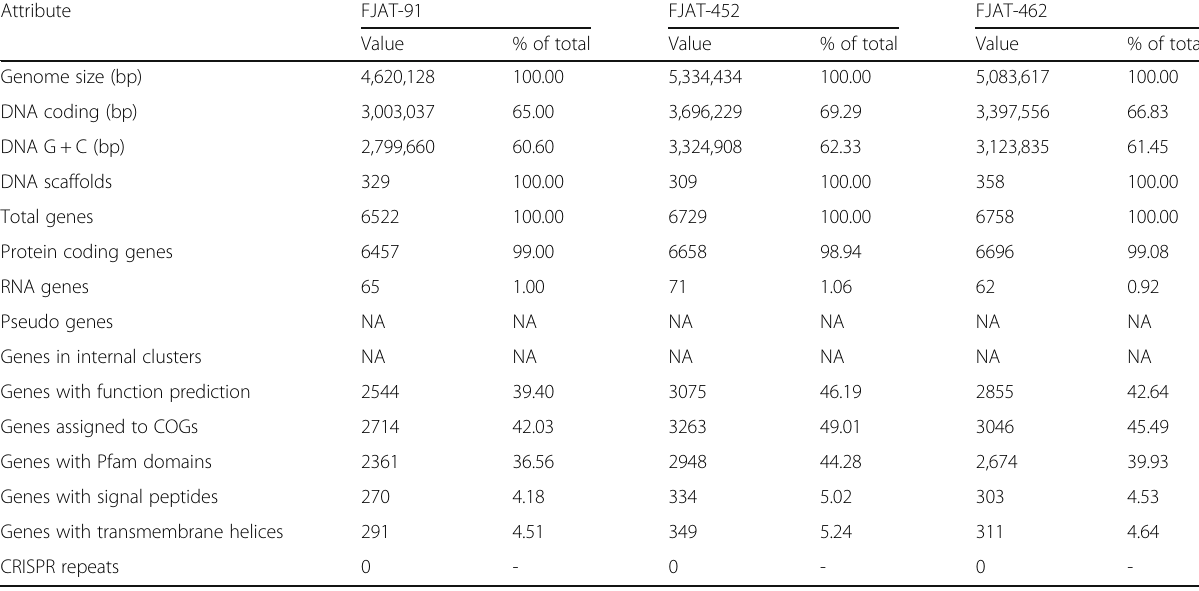
Table 5 Genome and annotation statistics of the three newly sequenced Ralstonia solanacearum strains Attribute Genome size (bp) DNA coding (bp) DNA G + C (bp) DNA